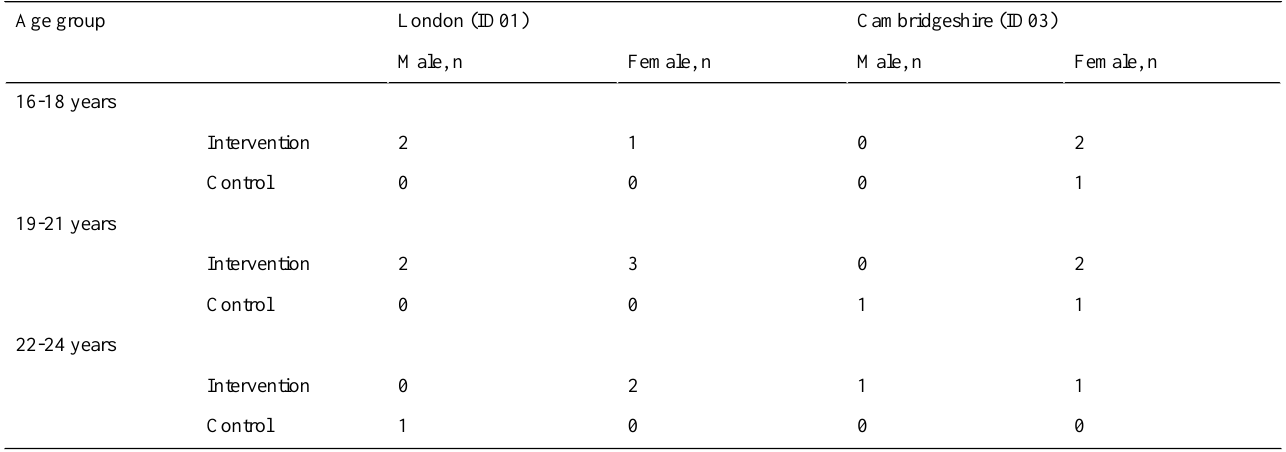
Table 1. Participant characteristics